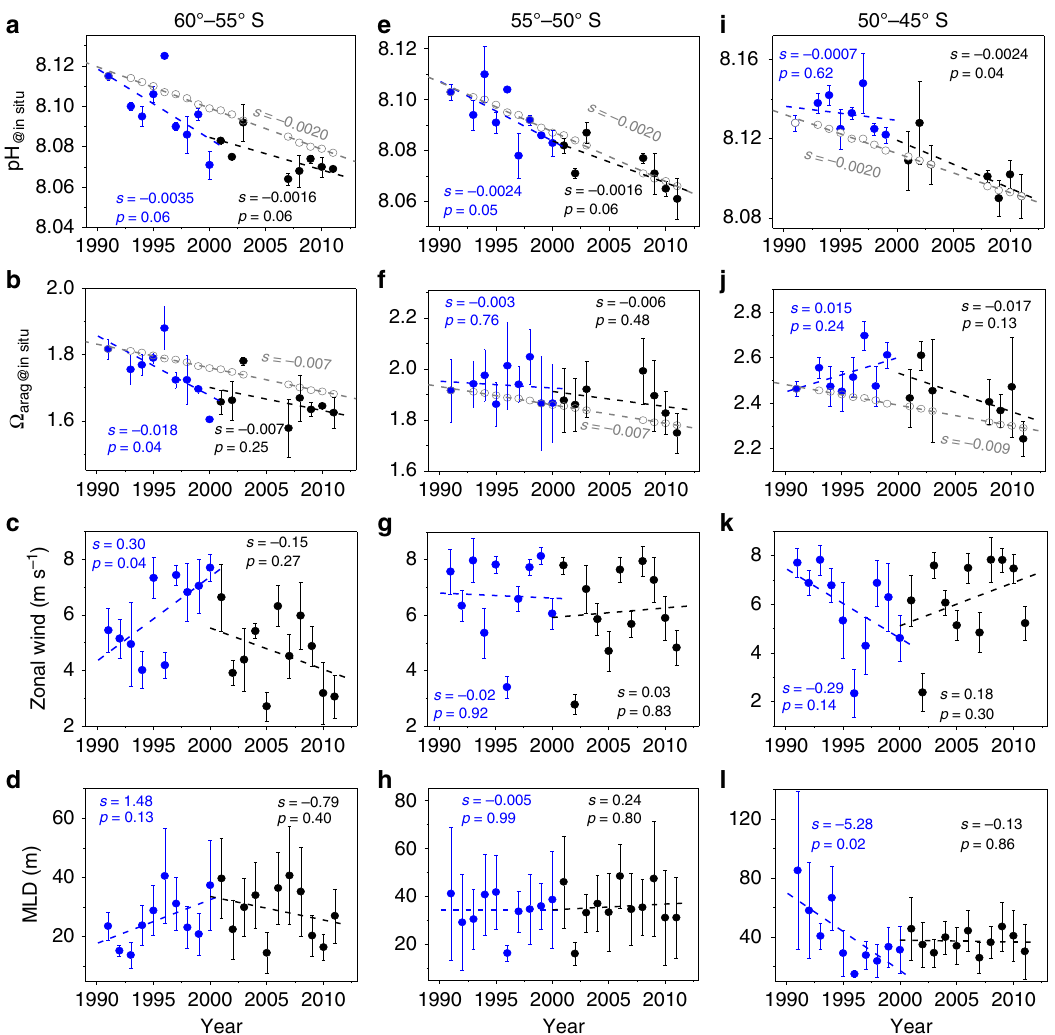
Fig. 3 Temporal variability in sea surface pH, Ω arag , zonal wind speed and mixed layer depth (MLD) in January in three latitudinal bands. a – d Sea surface pH at in situ temperature ( a , pH @in situ ), sea surface aragonite saturation state at in situ temperature ( b , Ω arag@in situ ), zonal wind speed ( c ) and mixed layer depth ( d , MLD) at 60° – 55° S. e – h show the same parameters but at 55° – 50° S; i – l shows the same parameters but at 50° – 45° S. The vertical bars show one standard deviation, which re fl ects the spatial variability within each latitudinal band. Linear regression analyses were performed for the periods 1991 – 2000 (blue) and 2001 – 2011 (black). Slopes ( s ), and p -values of the regression analyses are also shown (differentiated with blue and black colors for the two periods). Trends of p -value < 0.1 are regarded as signi fi cant statistically (90% con fi dence interval) due to the small sample numbers (<10). The open gray circles indicate the values computed due solely to the atmospheric CO 2 increase shown in Fig. 2c (see 'Methods'). Zonal wind speed and MLD are the mean values within 140° – 148° E in the three latitudinal bands, respectively. Note by de fi nition the trend of meridional Ekman transport is the same as that of zonal